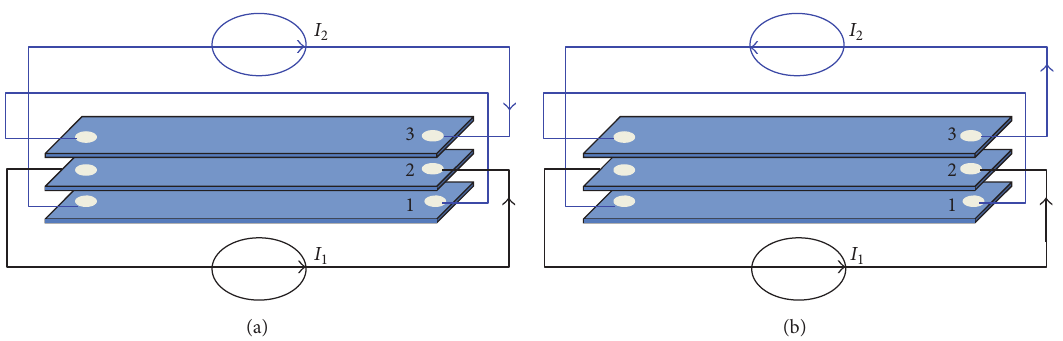
Figure 3: Schemes of (a) same-direction ( ↑↑↑ ) and (b) opposite-direction ( ↓↑↓ ) current feeding modes. The transport current applied to tape 1 and tape 3 is controlled by power supply ( 𝐼 2 ) and the transport current for tape 2 is controlled by 𝐼 1 . The critical current of tape 2 is measured by four-probe method.